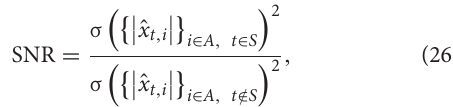
that peaked at the time of the spikes ˆ x ( t ) j . We also quantified